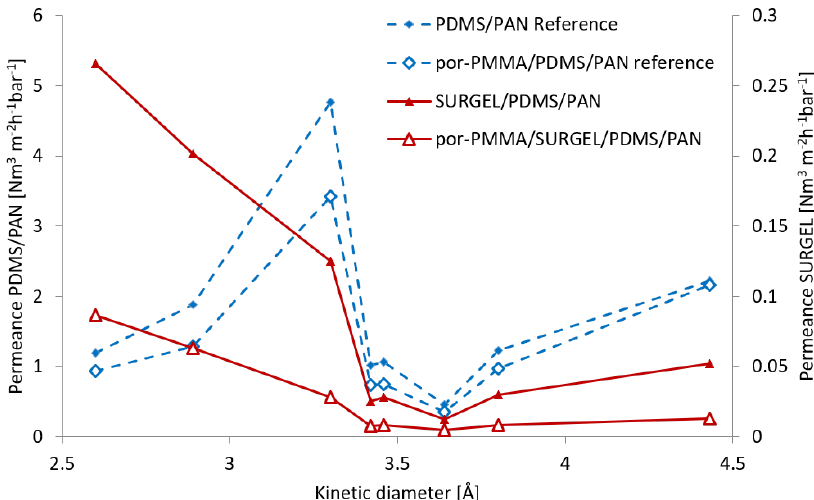
Figure 5. Measured gas permeances presented as a function of the penetrant kinetic diameters of the gases for the PAN / PDMS support membrane, the TFC membranes containing SURGEL and SURGEL + por-PMMA support on top, as well as the reference sample of por-PMMA on top of PAN / PDMS. Please note the di ff erent scales for SURGEL ( right ) and reference samples ( left ).